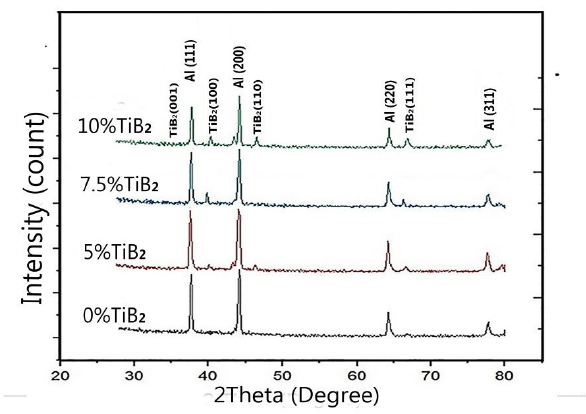
Figure 1: XRD Patterns of AA7010-TiB 2 in-situ composites